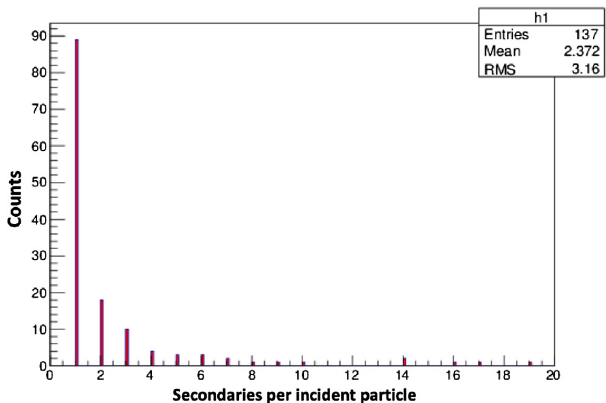
FIG. 9. Number of secondaries depositing energy in the DS by incident Touschek scattered positron.